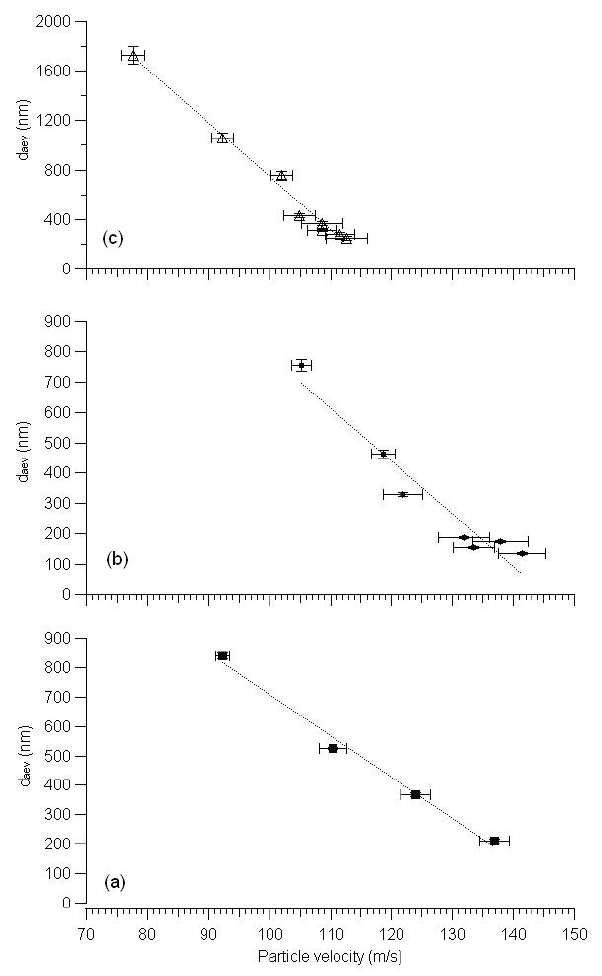
Fig. 4. Experimental calibration curves for aerodynamic particle sizing of the SPLAM instrument obtained for (a) – PSL, (b) – DOP and (c) – NaCl particles. The dash lines correspond to linear guideline.